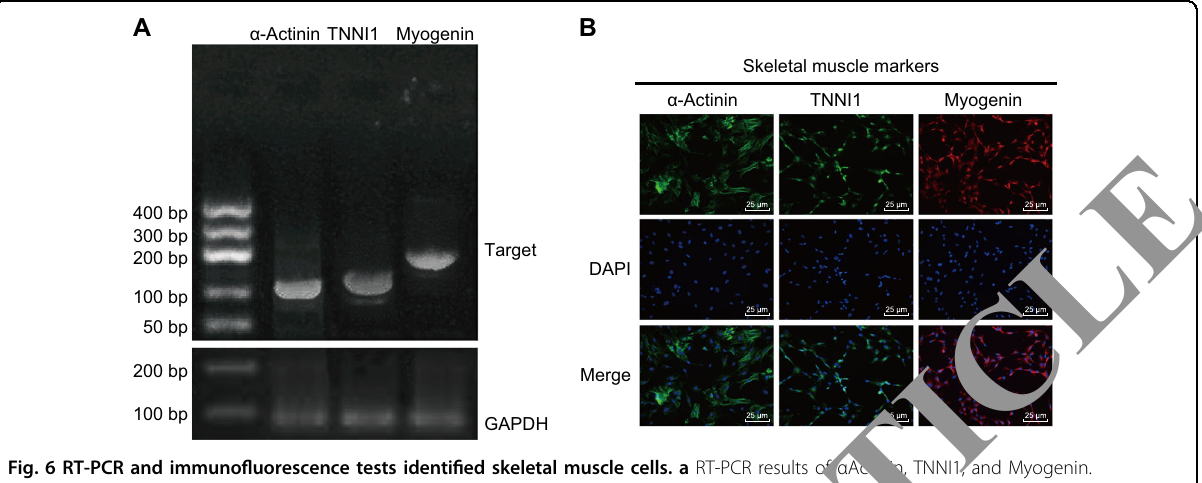
Fig. 6 RT-PCR and immuno fl uorescence tests identi fi ed skeletal muscle cells. a RT-PCR results of α Actinin, TNNI1, and Myogenin. b Immuno fl uorescence results of α Actinin, TNNI1, and Myogenin (×200); scale bar = 25 µm; the experiment was repeated 3